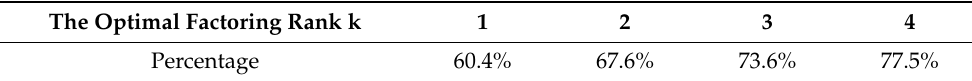
Table 6. Determining the optimal factoring rank k of